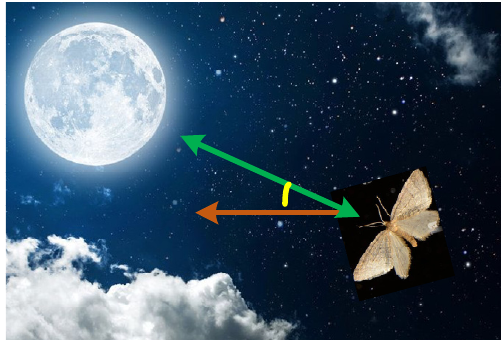
Figure 10. Transverse orientation of a moth.